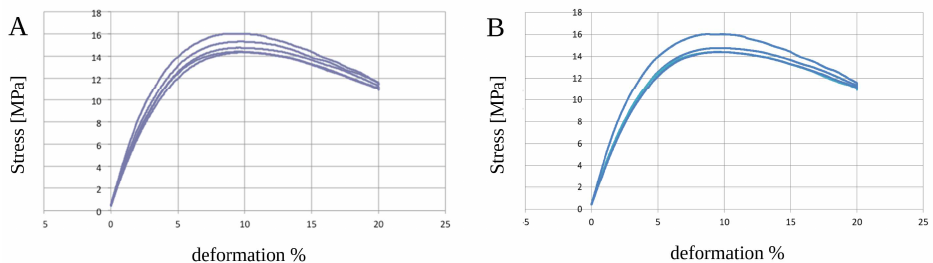
Figure 5. Graphical representations of the five analyses of unsterilized ( A ) and sterilized ( B ) poly(ε-caprolactone) (PCL) compounded with beta-tricalcium phosphate 20% (PCL+β-TCP 20%) samples. No differences in deformation (%) were noticed in the range of observation.